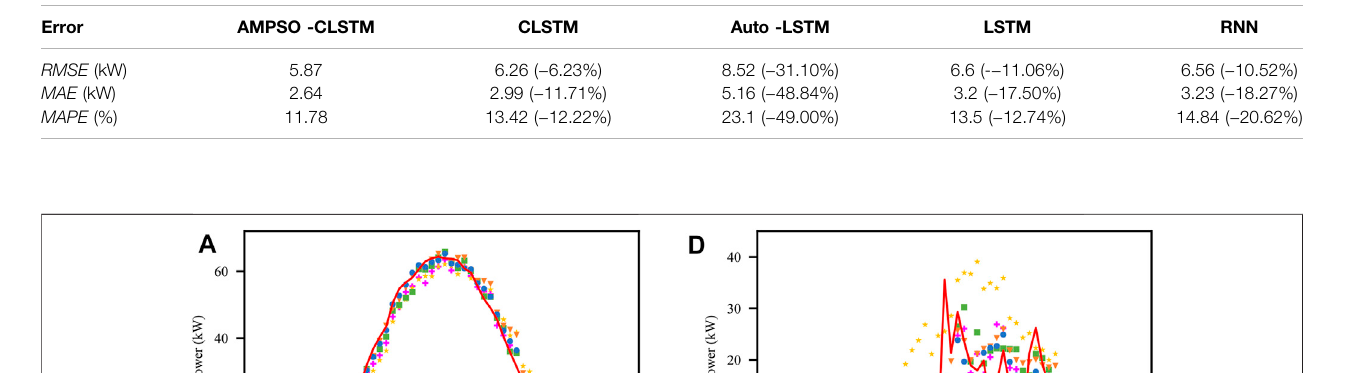
Frontiers in Energy Research |